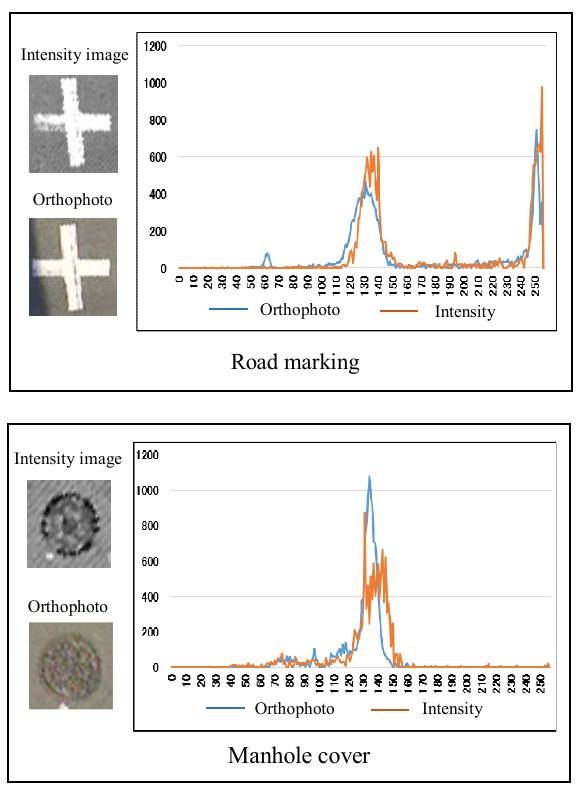
Figure 19. Comparison of intensity by material